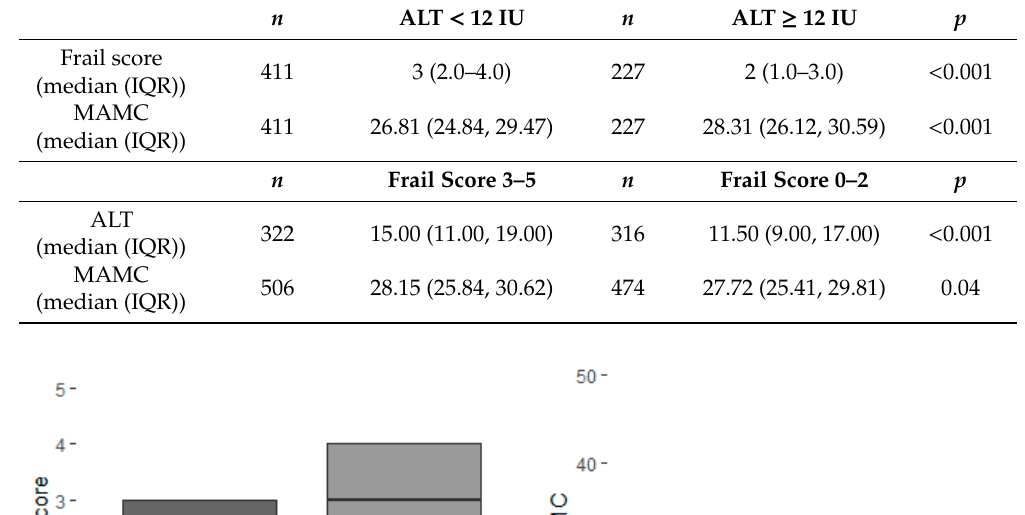
Table 3. Associations between di ff erent sarcopenia and frailty indices.